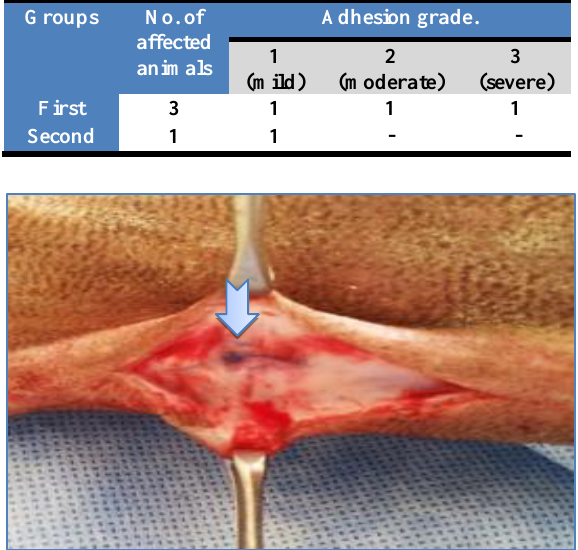
Table, 3: Shows the adhesions at four months post- treatment in the two groups.